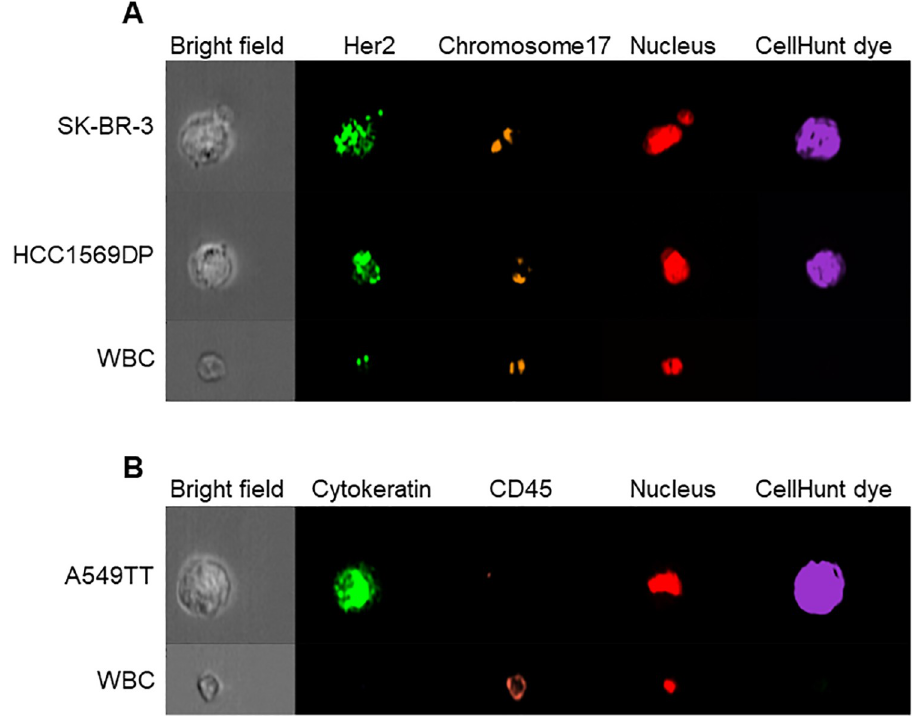
Fig 4. Cell images of each cell line and white blood cells obtained by imaging flow cytometry. (A) FISH staining image of SK-BR-3, HCC1569, and white blood cells. HER2 (green) and chromosome 17 (red) were stained using the Cytocell HER2 FISH probe, and the nucleus was stained using DRAQ5. (B) Immunostaining image of A549TT and white blood cells. Cytokeratin (green) and CD45 (red) were stained by specific antibodies. The nucleus was stained with Hoechst 33342. https://doi.org/10.6084/m9.figshare.12433484.v1.